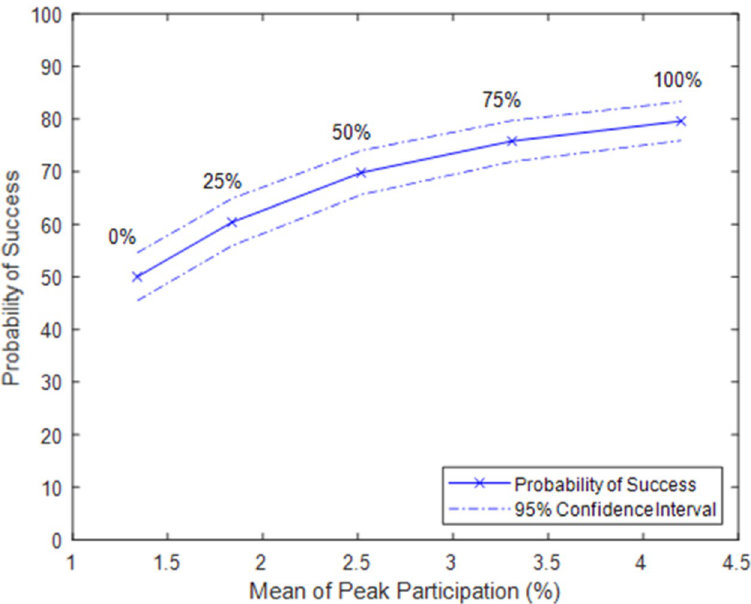
Fig 2. Participation and success increase with Percent Immediate Protest. Note: data points labeled with Percent Immediate Protest.